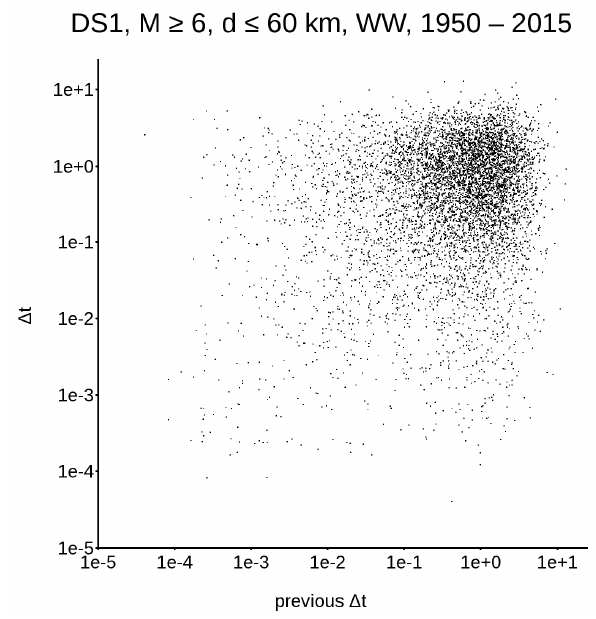
Figure 1. Survival probability ( left ) and (cid:2019)(cid:4666)(cid:1986)(cid:1872)(cid:4667) ( right ) for datasets 1–4 (DS1–DS4). Solid lines refer to empirical functions, while dashed lines refer to Poissonian ones.